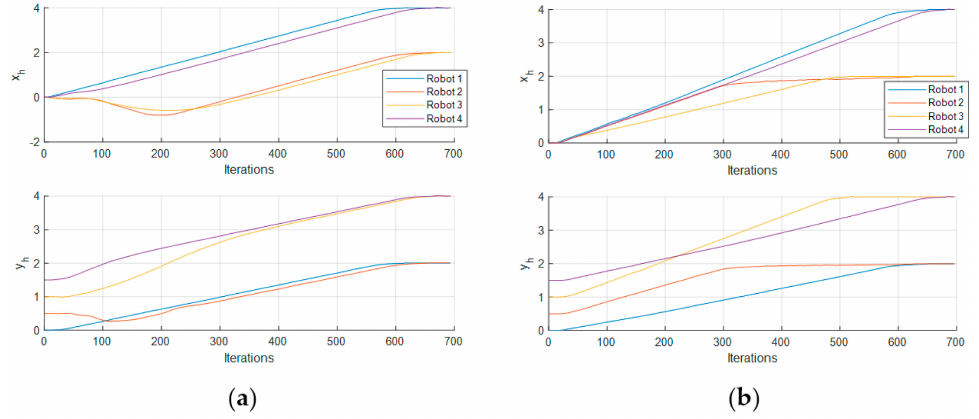
Figure 23. Trajectories along iterations in the comparison tests without collision avoidance: ( a ) Scheme proposed in this paper; ( b ) scheme proposed in